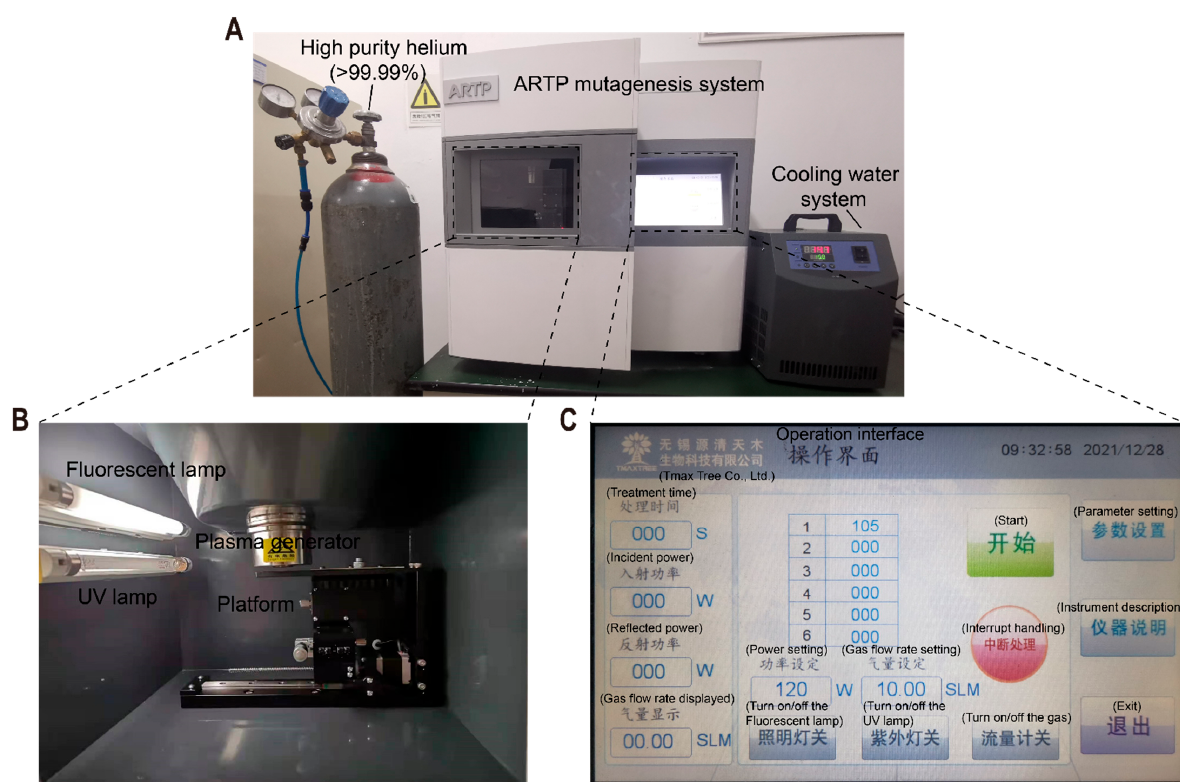
Figure 2. Pictures of the ARTP mutation breeding system. ( A ) The front view; ( B ) The operation chamber; ( C ) The operation